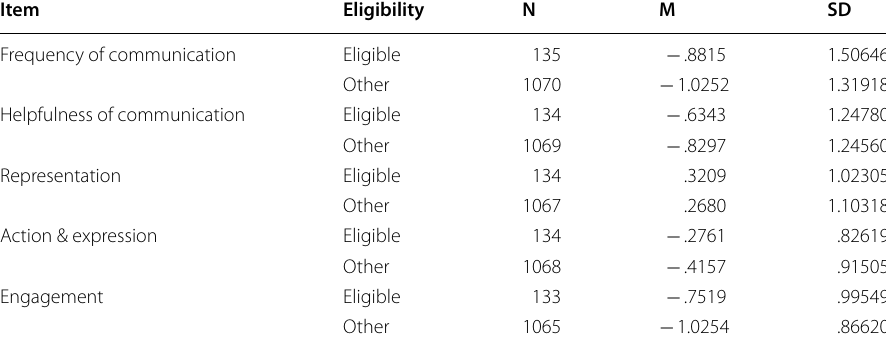
Table 3 Descriptive statistics for quality of instruction items for students eligible for disability services and other